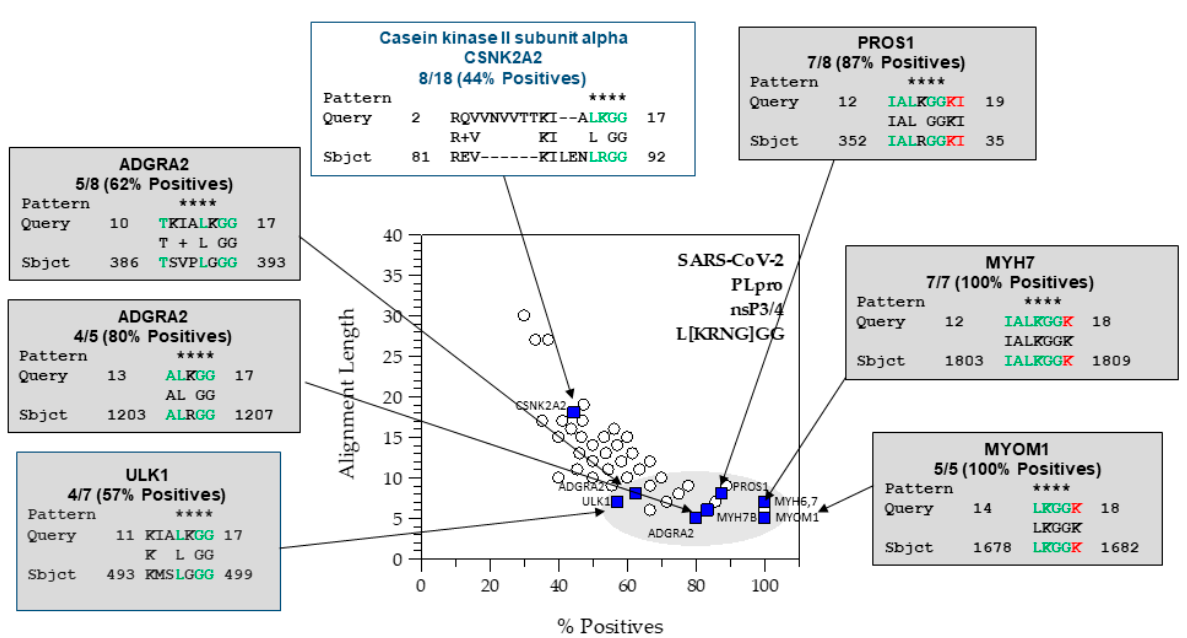
Figure 3. The SARS ‐ CoV ‐ 2 PLpro PHI ‐ BLAST hits using a 2D graph of alignment length vs. percent positives. Astrisks show the match to the PHI ‐ BLAST pattern. In green are the residues N ‐ terminal to the scissile bond and in red are the residues C ‐ terminal to the scissile bond that match a viral protease cleavage site sequence. The Python script will generate the most probable host targets based upon subsite tolerances extracted from known cleavage sites (e.g., L[KRNG]GG] for the PLpro SARS2 ). The 2D graph shows a cluster capturing hits with protease cleavage sites and relationships to pathology such as the anti ‐ coagulant protein, PROS1, VWF (overlapped with ADGRA2 at 62.5%, 8), the cardiac myosins (MYH7, MYH6), and sarcomeric protein, MYOM1. The alignments in the upper left are potentially cleavable, but have gaps and shorter runs of matching residues.